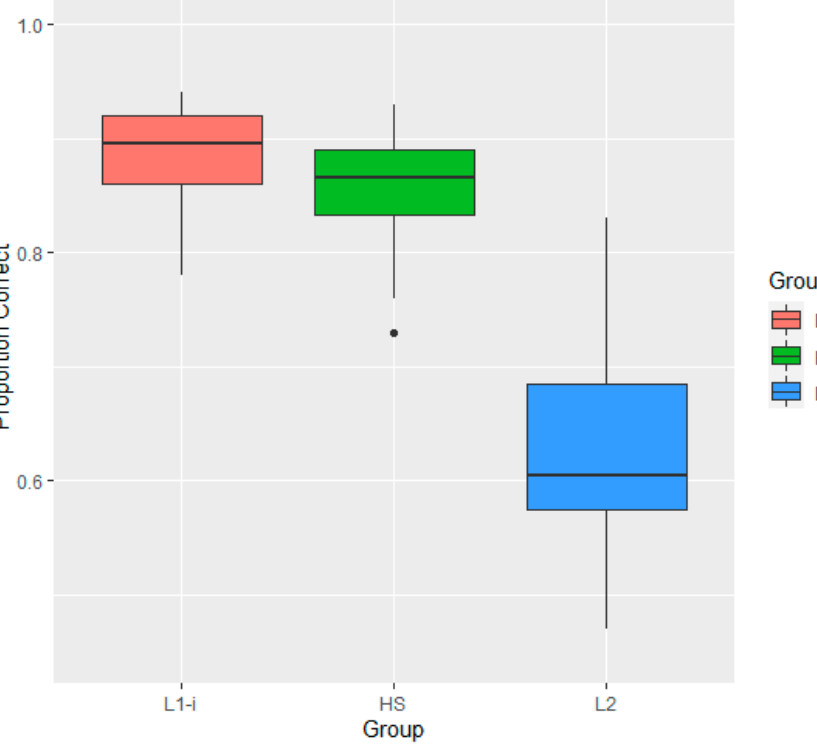
Figure 4. Box plots of the lenis–aspirated stop contrast separated by speaker. ( a , b ) show a compari- son of VOT and F0, respectively.